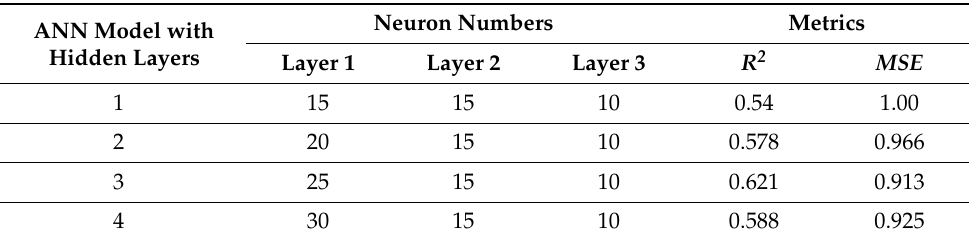
Table 5. Predicted performances of all ANN models with variant neuron numbers.